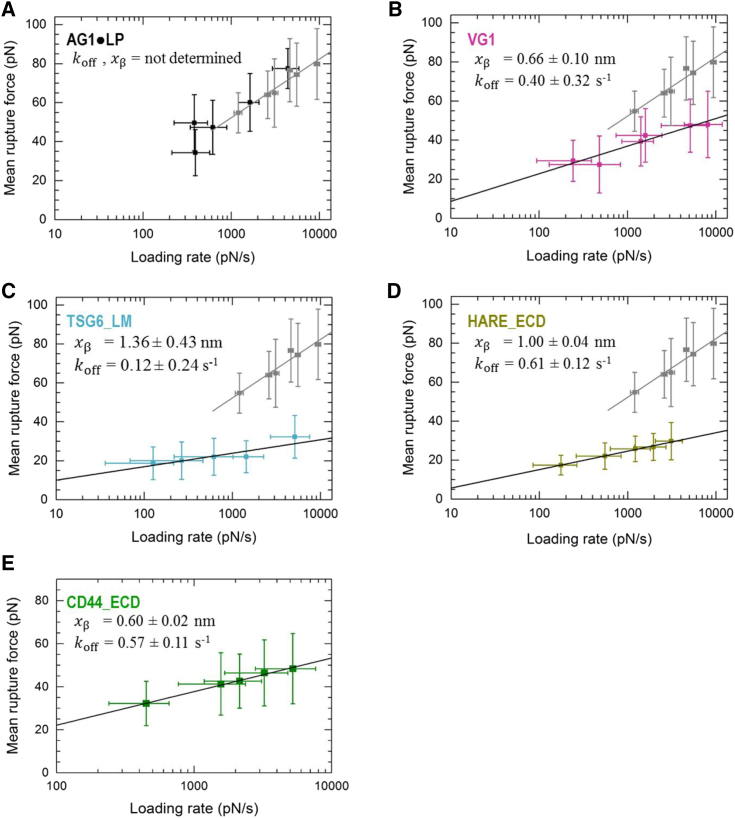
Dynamic force plots for the four hyaladherins studied here (A–D; obtained from Fig. 4) and for CD44_ECD (E; Fig. 4 from (16)). Mean rupture forces are presented as mean ± SD, and black lines are fits with the Bell-Evans model (resulting kinetic parameters are indicated; data for AG1⋅LP were not fitted, as here the streptavidin⋅biotin anchor is the weakest link). Dynamic force spectra for the rupture of streptavidin⋅biotin bonds are shown (in gray) for comparison (from (16); see also Fig. S6). To see this figure in color, go online.